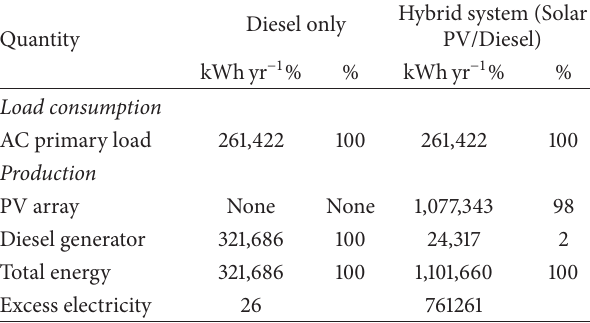
Table 9: Comparison of simulation results of electricity production (kWh yr −1